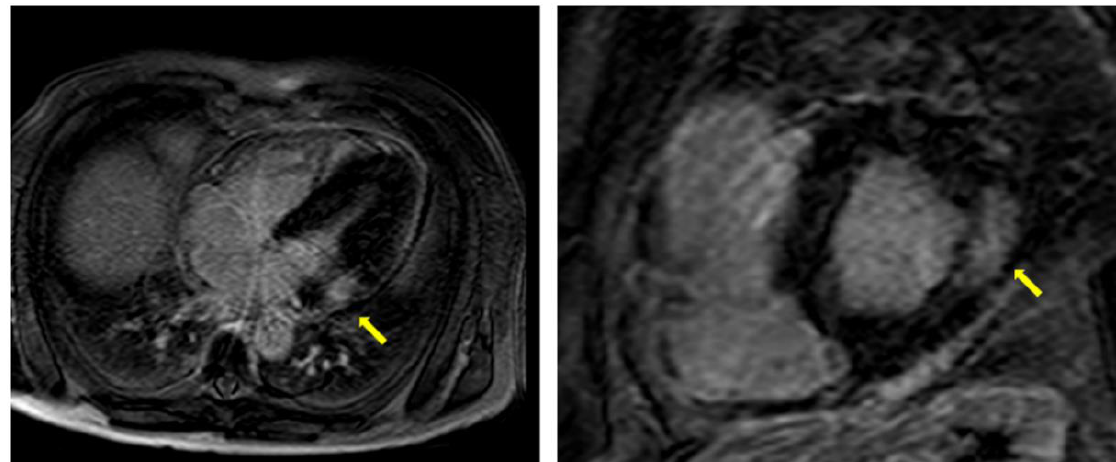
Figure 6. LGE-CMR shows typical LGE pattern at the mid-wall in the basal infero-lateral area of the left ventricle in two different AFD patients (yellow arrow).